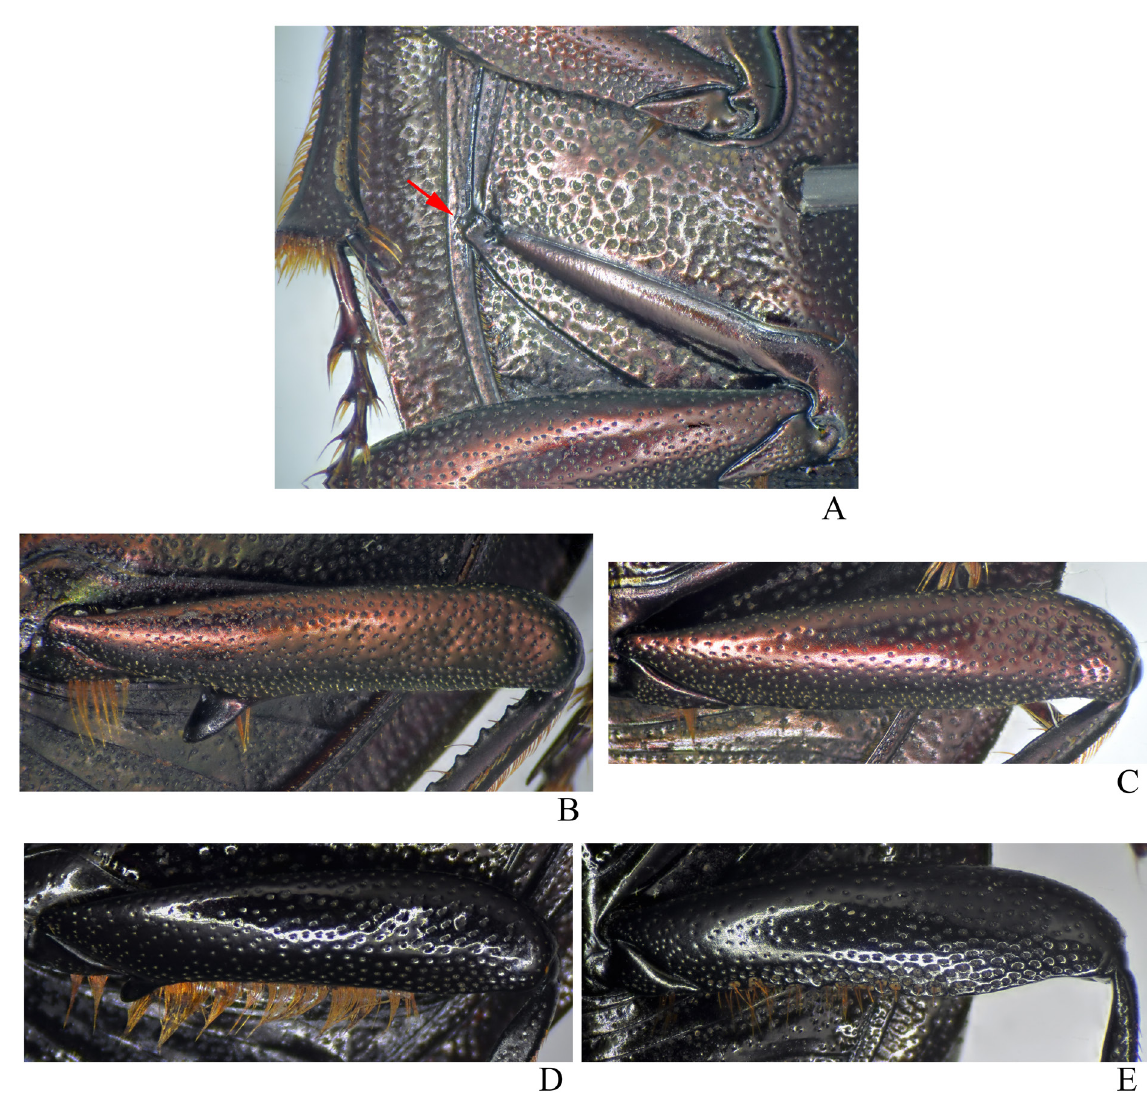
Fig. 19. Posterior legs. A . Metacoxa of Streblopus opatroides van Lansberge, 1874. Arrow shows the lateral spur present in both sexes of both species. Note also that the spur covers the epipleura and possibly maintains the elytra pressed against the body, thus avoiding loss of water or the entry of sediment beneath the elytra in a similar way to that hypothesized for the metanepisternal tab of the Phanaeini and other tunneller groups (Edmonds 1972; Cupello & Vaz-de-Mello 2016). B‒E . Metafemora